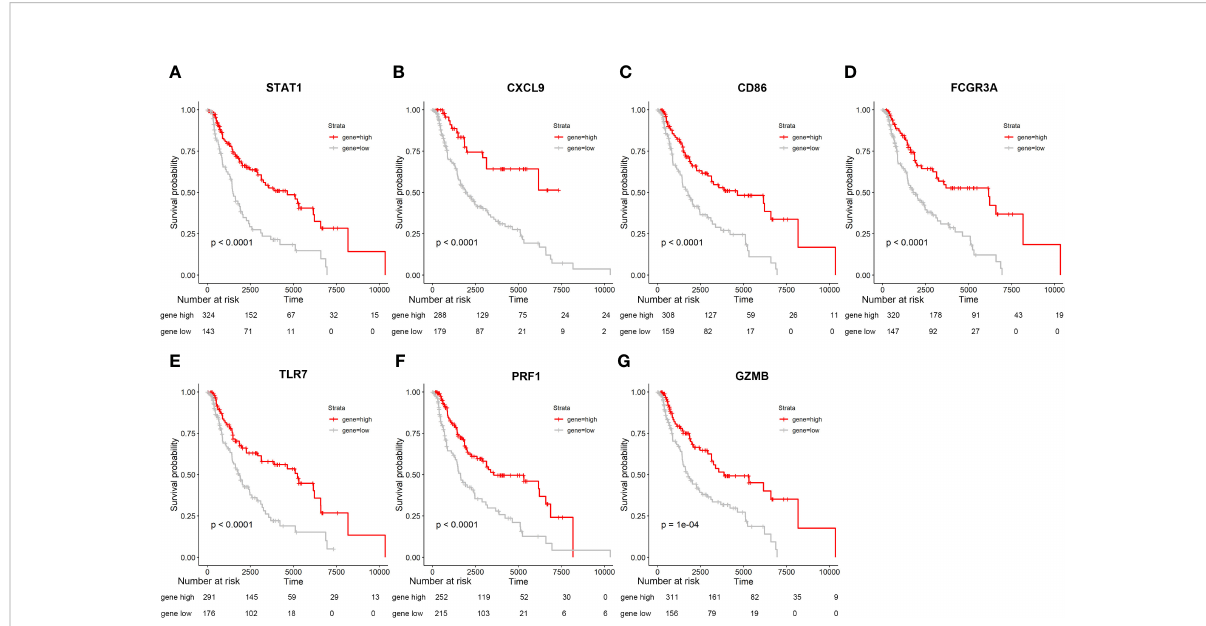
FIGURE 4 Seven Kaplan-Meier curves are based on samples from the GTEX and TCGA databases, extracting data from these seven genes and combining them with survival times. Speci fi c information on the number of people is shown in the fi gure. (A-G) Survival analysis for seven key molecules. Seven key molecules which includes STAT1, CXCL9, CD86, FCGR3A, TLR7, PRF1,